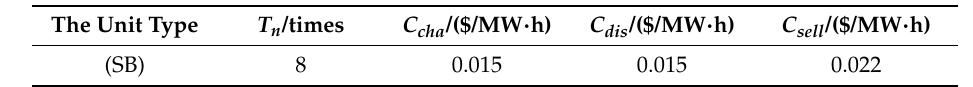
Table 6. Data of storage battery.